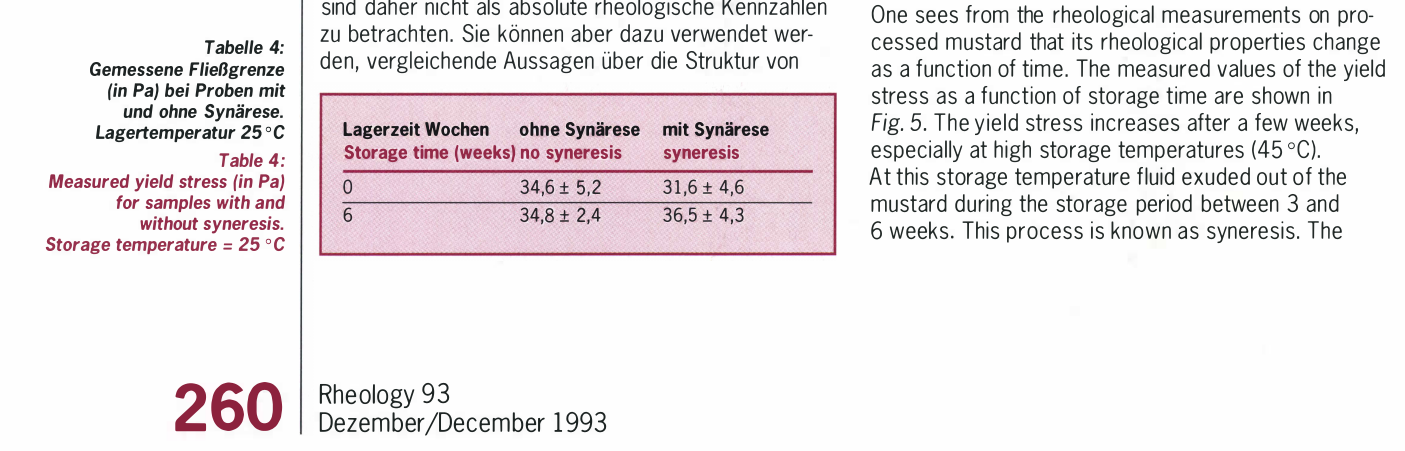
Table 4: Measured yield stress (in Pa) for samples with and without syneresis.